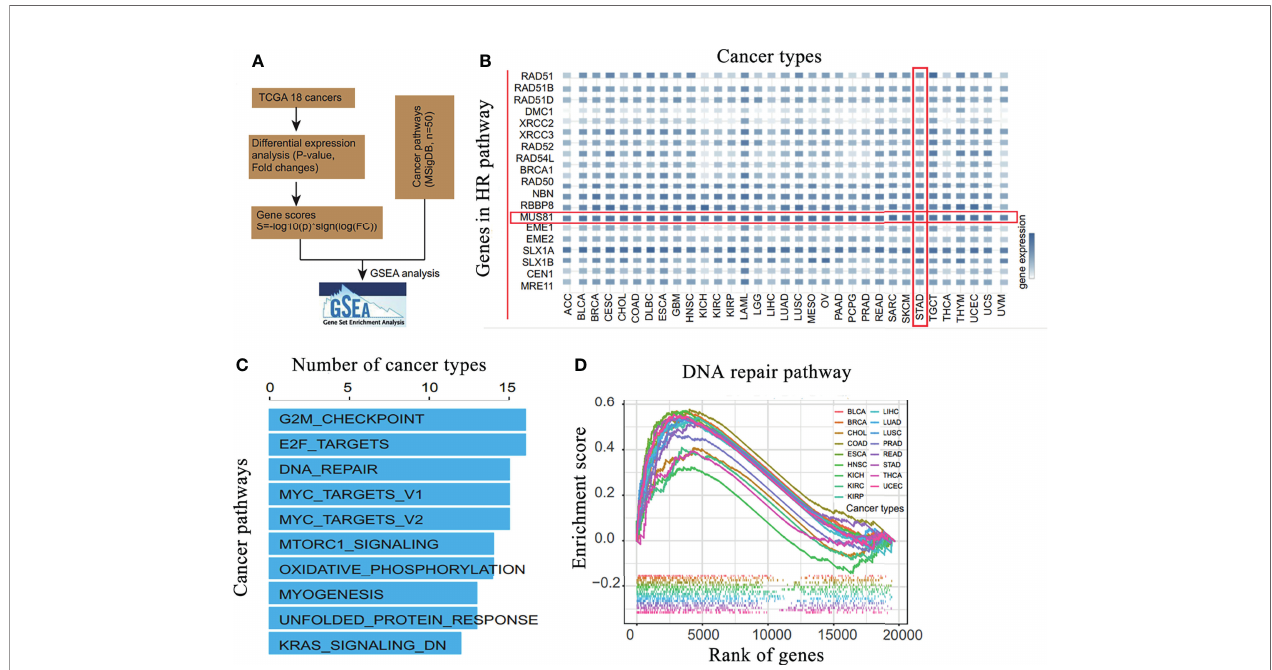
FIGURE 1 | MUS81 is overexpressed in gastric cancer and is enriched in DNA damage repair pathways in malignant tumors. (A) Bioinformatics analysis process. (B) Analysis of the differential expression of DNA damage and repair-related molecules in 18 common malignant tumors in TCGA database suggests that MUS81 is overexpressed in gastric cancer. (C) Gene set enrichment analysis of MUS81-related enrichment signaling pathways in malignant tumors. (D) Enrichment of MUS81 in DNA damage repair pathways in malignant